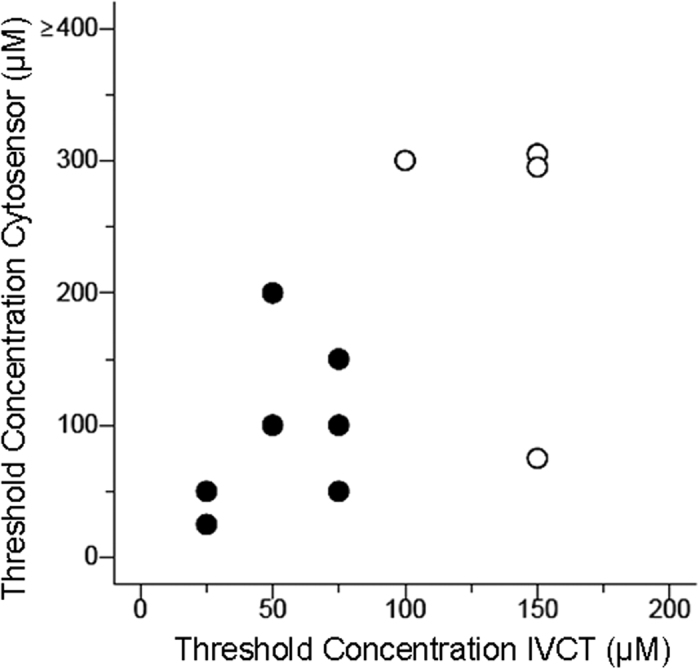
Scatter plot of IVCT data and microphysiometer data at given 4–CmC concentrations reflecting a supra–threshold drug response (threshold definitions, 25% increase above baseline value of acidification rate in the Cytosensor test [ordinate] and 2 mN concentrations force in the IVCT [abscissa]).